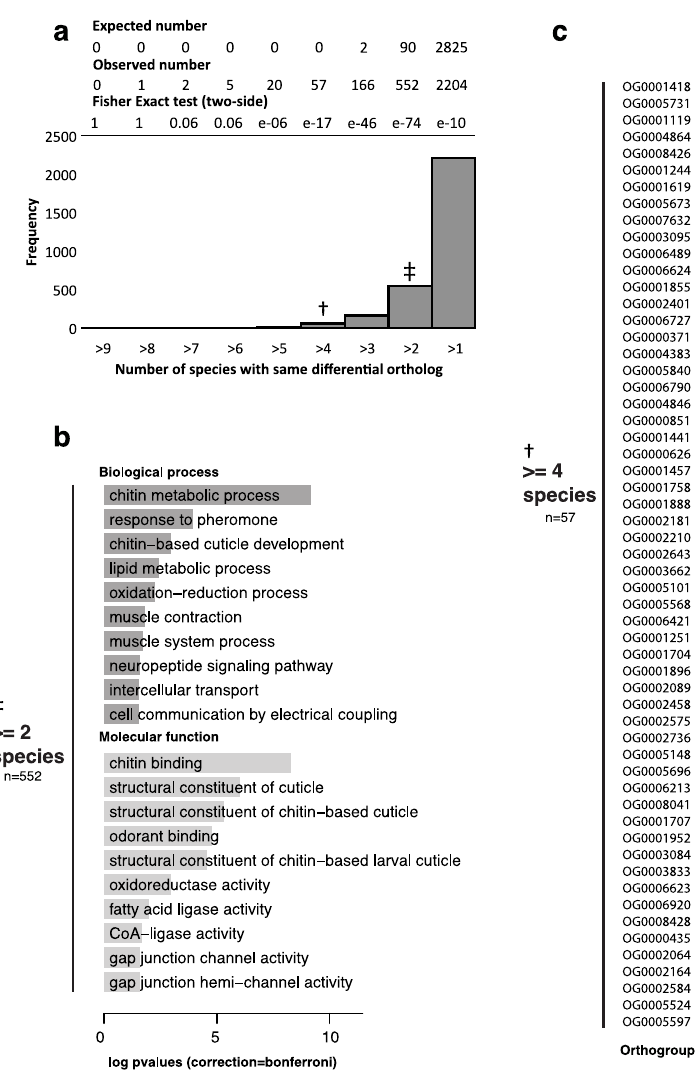
genes;eitherqueenorworkerupregulated;withoutneedingtheDEGtobeinsame casteupregulateddirection),usingabackgroundofallgenestestedacrossthenine species. P valuesaresingle-tailedandBonferronicorrected. c Heatmapshowingthe differential genes that are caste-biased in at least four species (identi fi ed using edgeR) using the orthologous genes present in the nine species. In cases where threeisoformsexistforasinglespeciesorthogroup,onlytheisoformwithgreatest expressionwasconsidered,plusatleast2speciescouldhavemissinggenedatafor each orthogroup. Listed for each species (in brackets), is the total number of orthologous differentially expressed genes per species. Metapolybia Blast hits are listed along (right) with orthogroup name